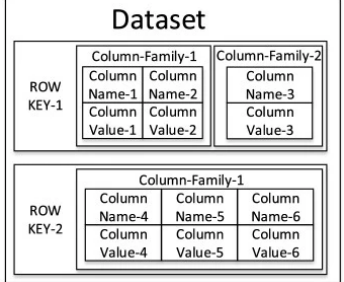
Figure 3 . Column Store Database (Grolinger et al., 2013)